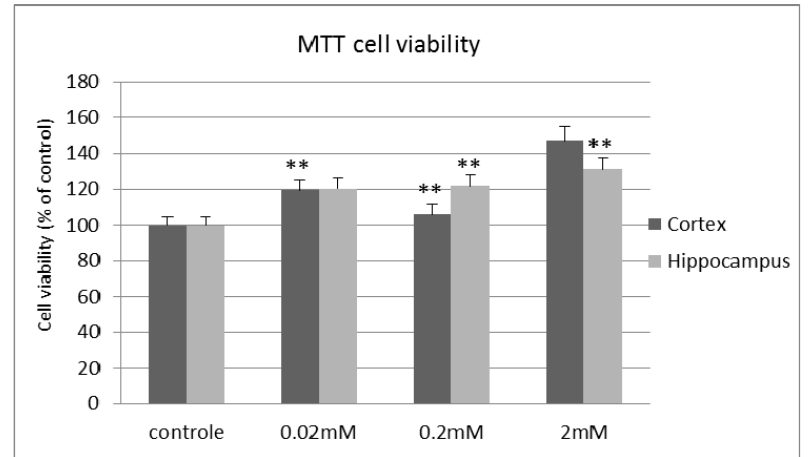
Figure 1. Viabilities of primary cultures of hippocampal and cortical neurons exposed to different concentrations of lithium chloride for 7 days ( n = 5, ** p < 0.01).